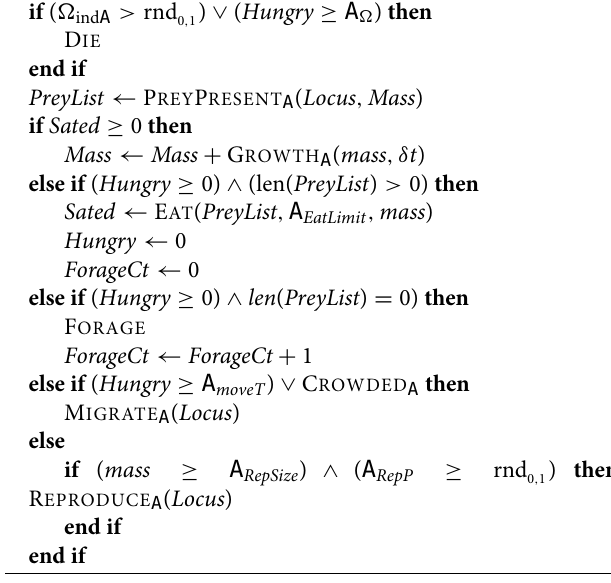
Algorithm 6 | Basic processing pass for herbivores and